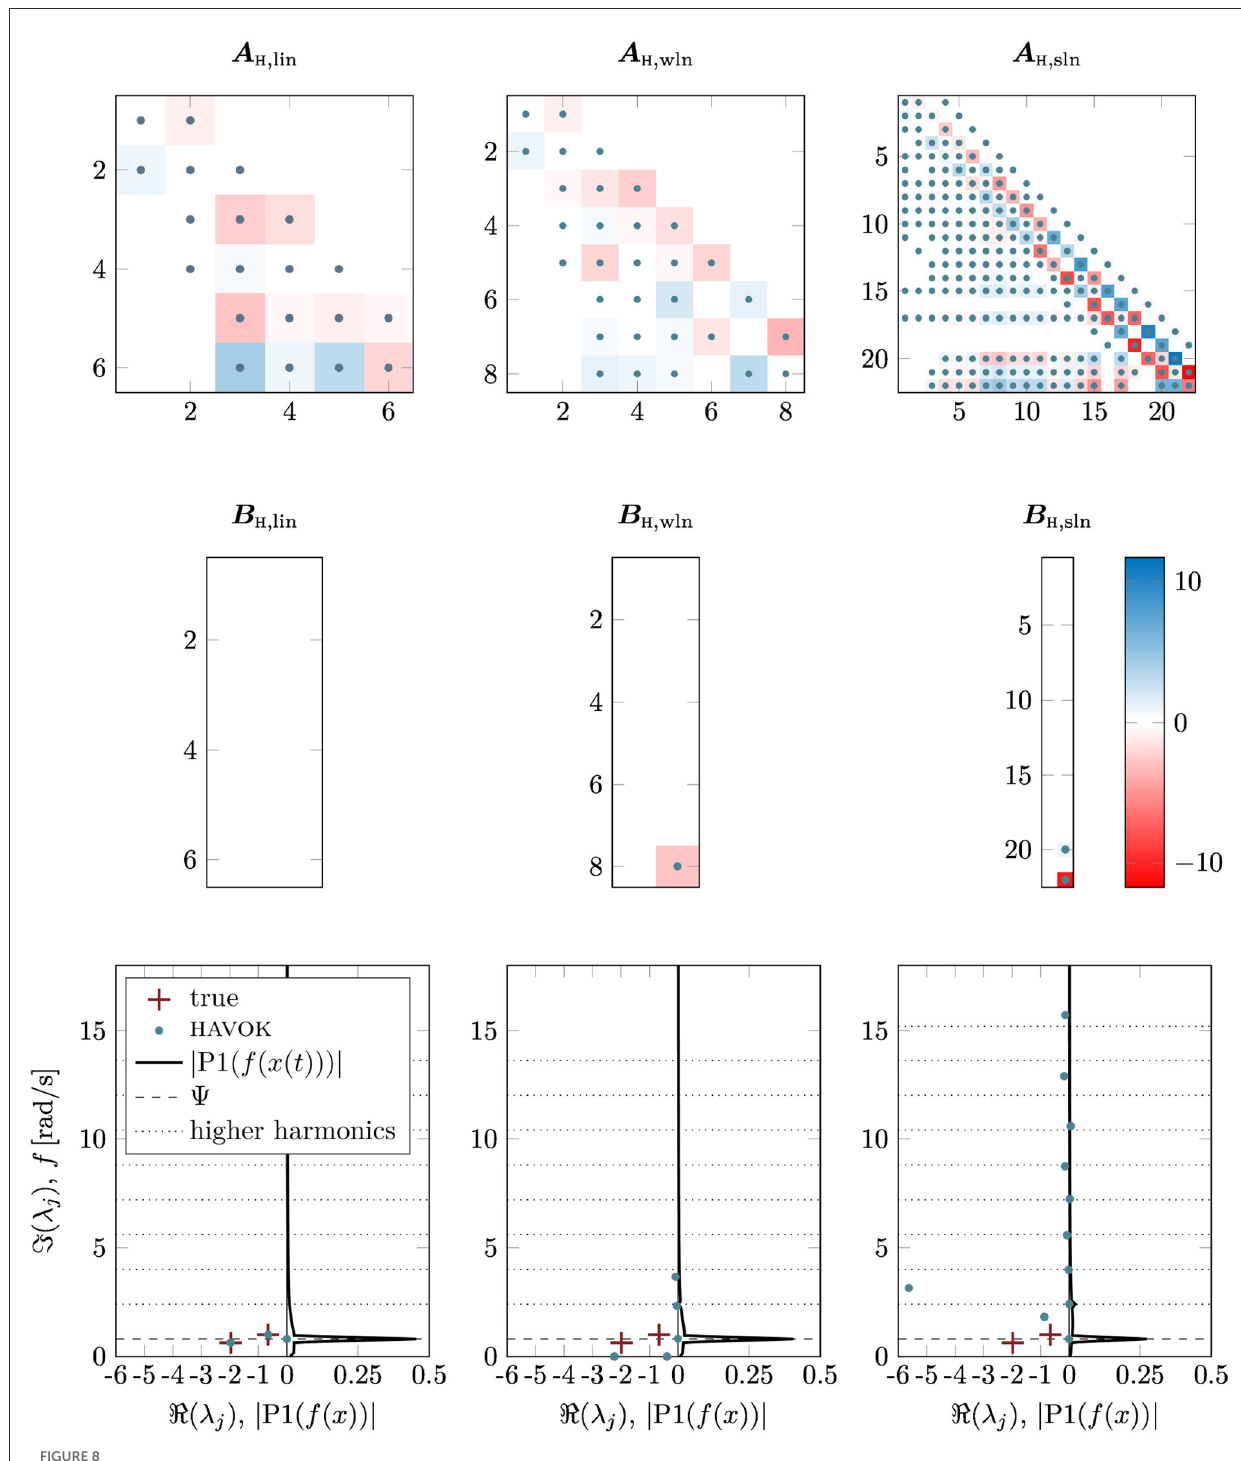
FIGURE8 HAVOK models a linear, weakly non-linear, and strongly non-linear double mass oscillator. The state matrices A H,lin , A H,wnl , and A H,snl are shown on top, with the input matrices B H,lin , B H,wnl , and B H,snl below. The system eigenvalues λ j of the true underlying DMO system, and the HAVOK model are shown on the bottom, along with a frequency spectrum of the input time series P 1 | f ( x ( t )) | , the forcing frequency 9 and its higher harmonics.